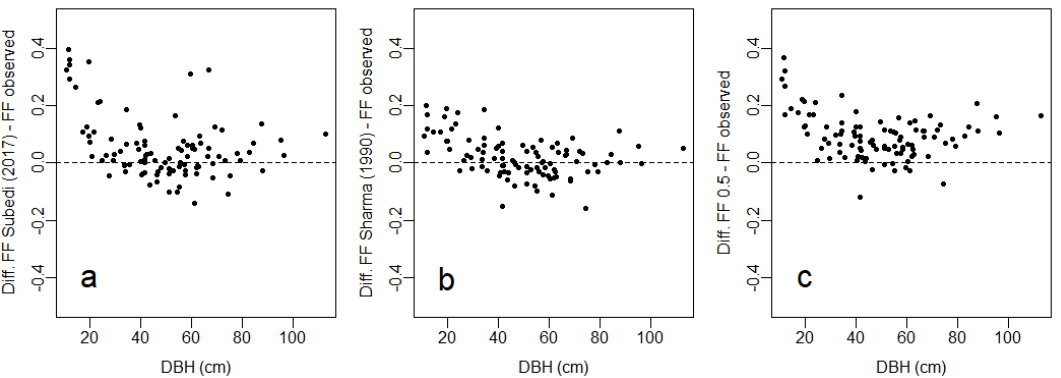
Figure 5. Error of three FF estimates compared with our observations (Difference = predicted FF – observed FF). From left to right we used ( a ) FF from volume functions by [19], ( b ) FF from volume functions by [18] and ( c ) FF of 0.5.